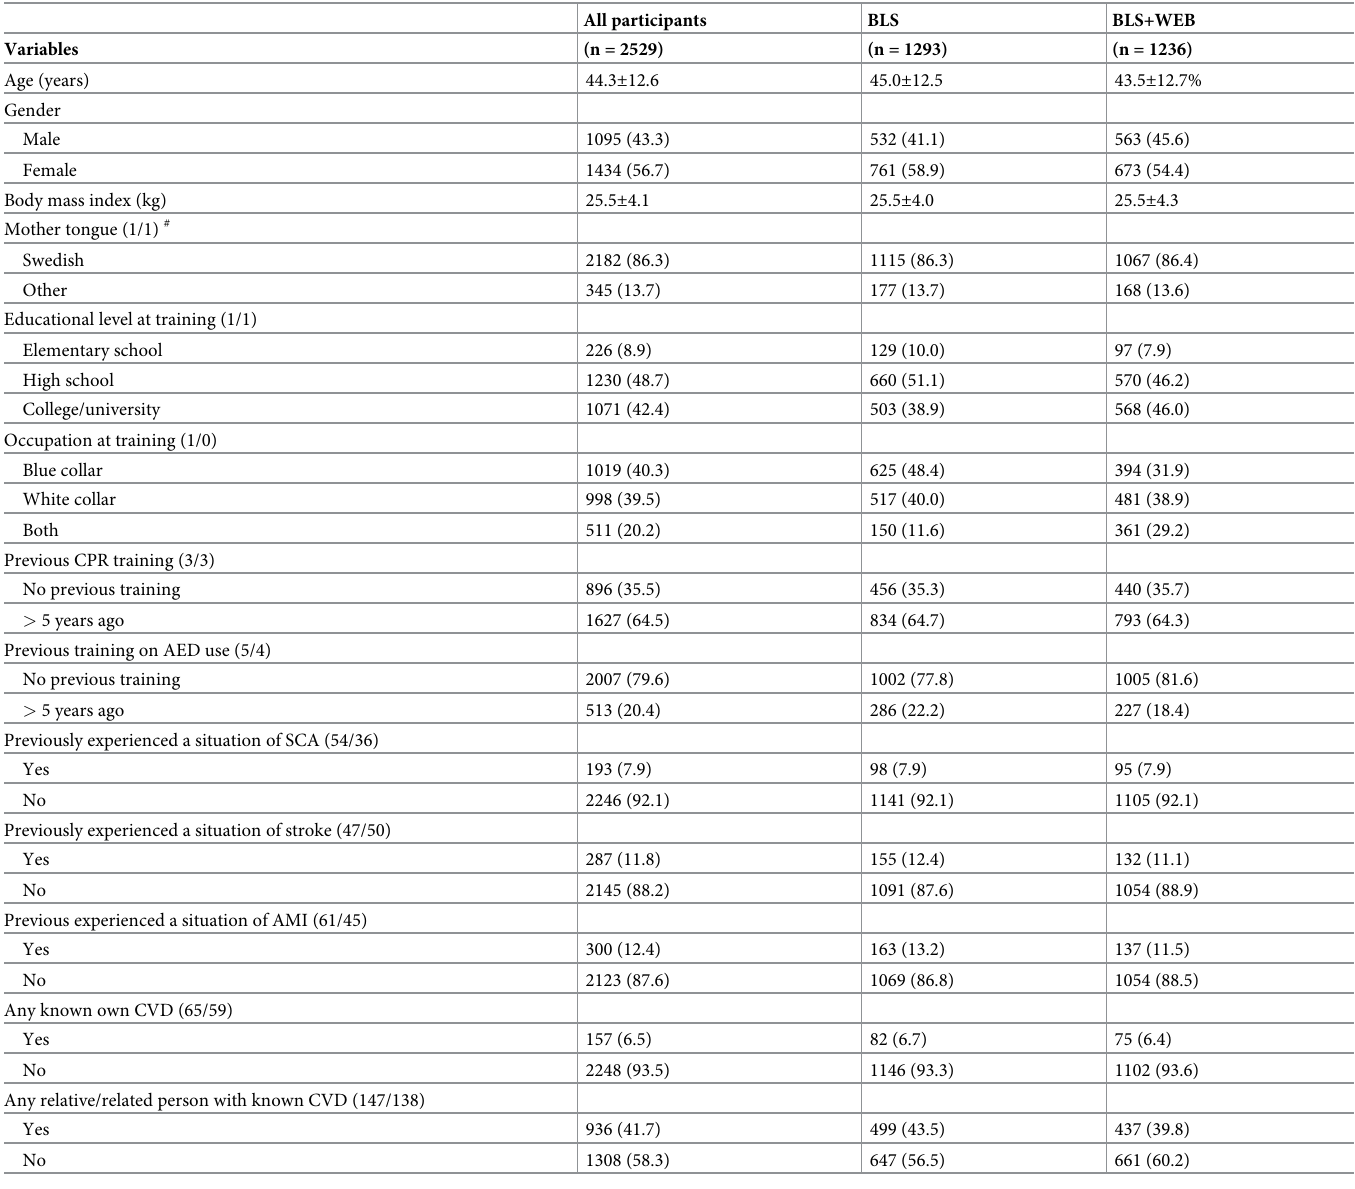
Table 1. Characteristics of participants.